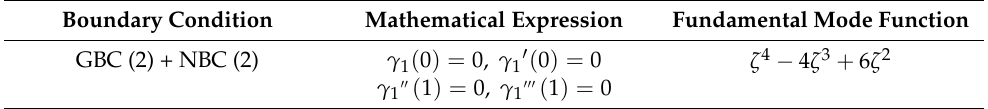
Table 3. Fixed-free fundamental mode function ( γ 1 ).